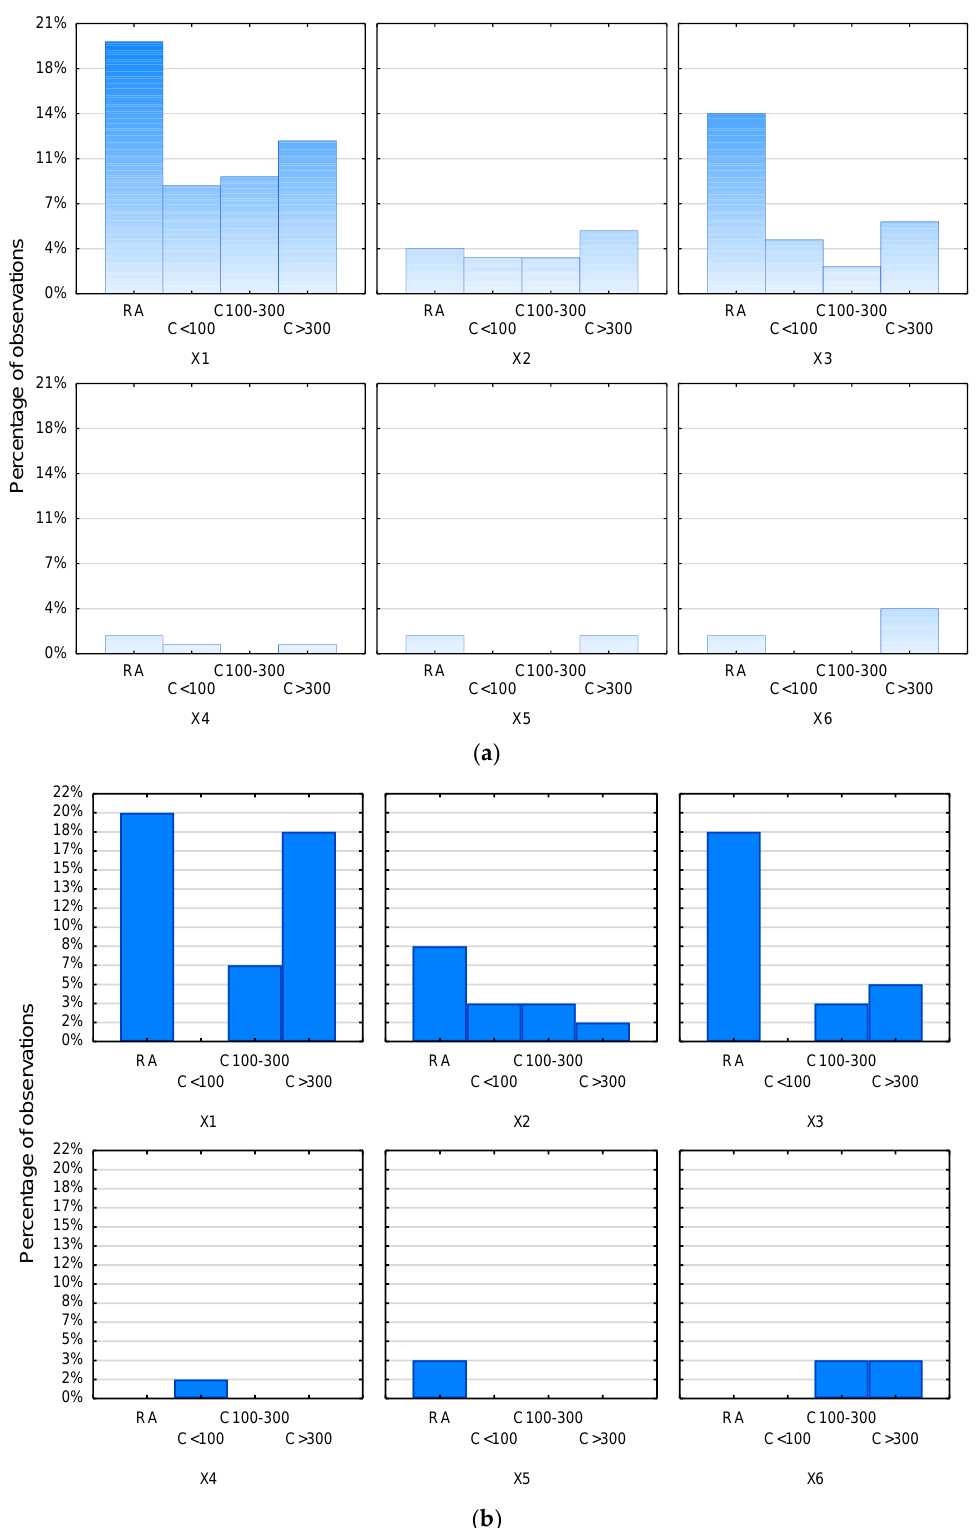
Figure 2. ( a ). Places of women’s daily food shopping. Histogram categorized by the variable place of residence. ( b ). Places of men’s daily food shopping. Histogram categorized by the variable place of residence. Abbreviations: X1-hypermarket, X2-via internet, X3-local store, X4-wholesale (cash and carry wholesalers), X5-armer, X6-marketplace, RA-rural, C100-city with up to 100,000